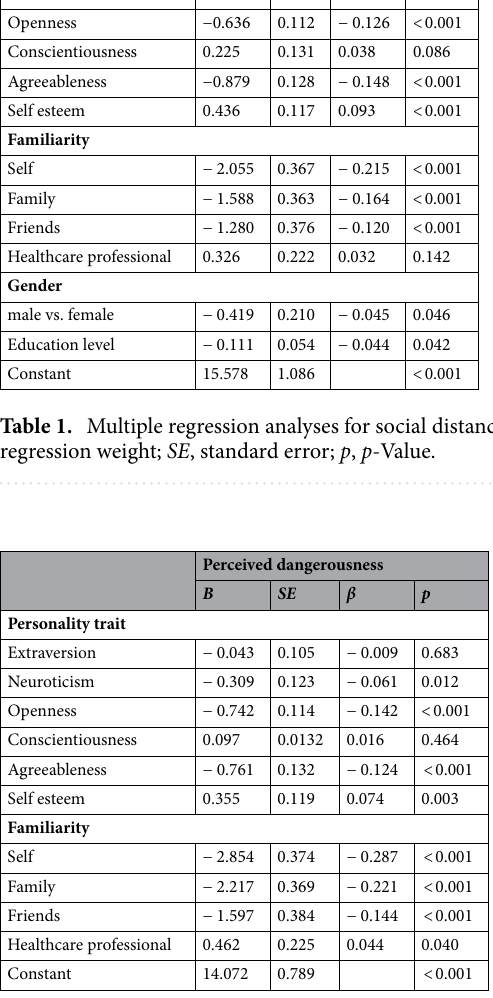
Table 2. Multiple regression analyses for perceived dangerousness. B, unstandardized regression weight; β, standardized regression weight; SE , standard error; p , p -value.